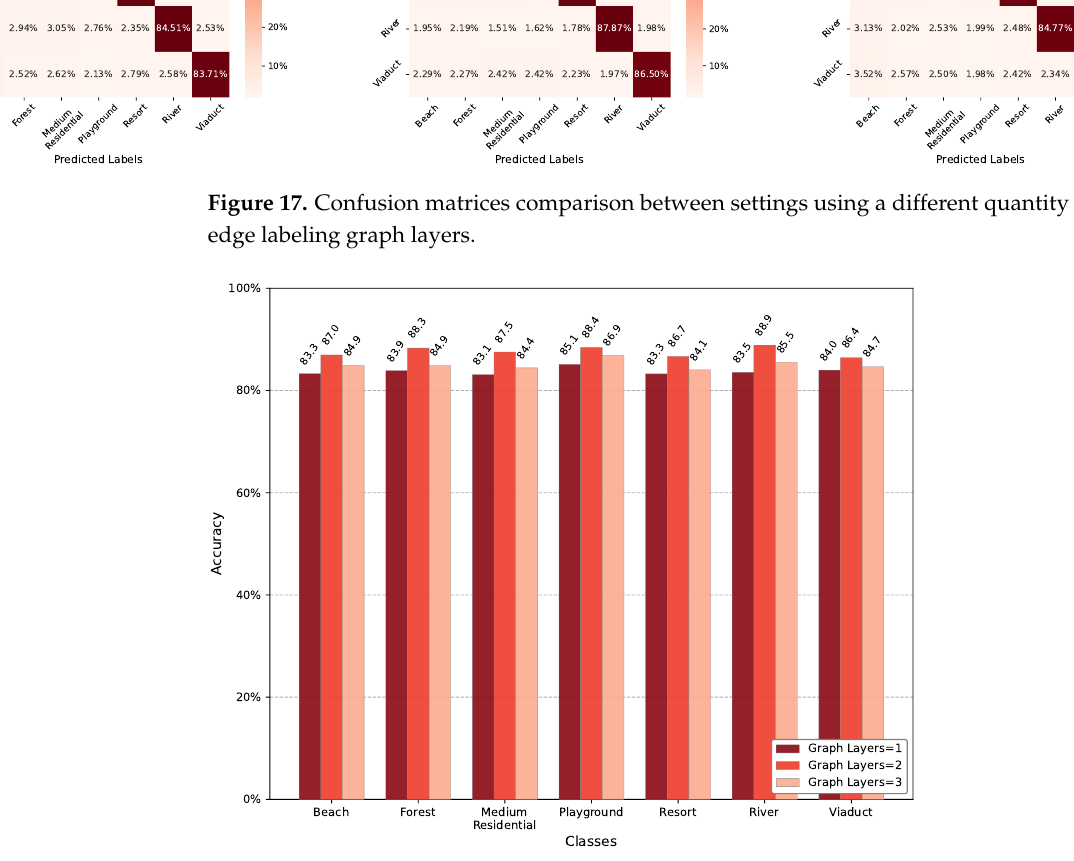
Figure 18. Comparison of class accuracies when a different number of Bayesian edge labeling graph layers is